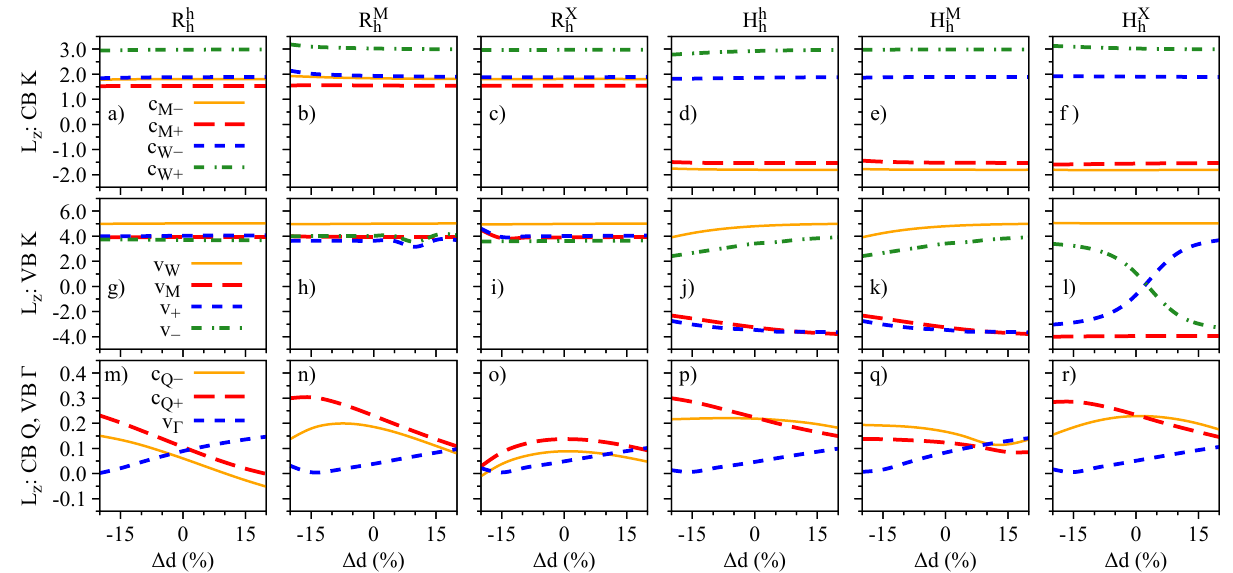
Figure 9. Same as Figure 5 but as a function of the interlayer distance variation.